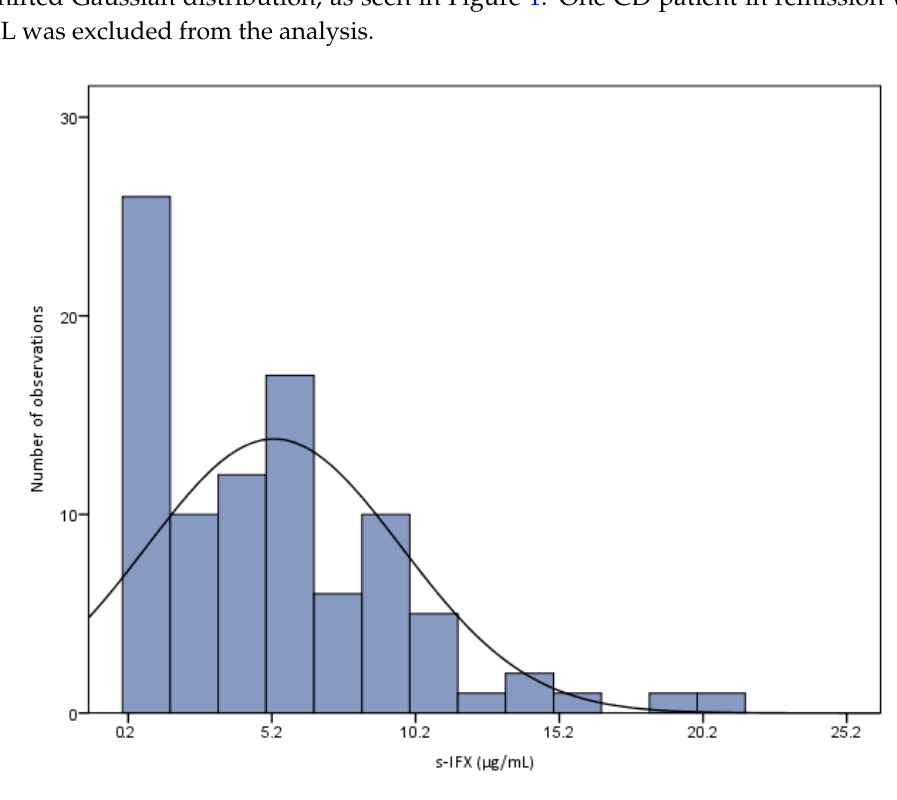
Figure 1. The distribution of serum infliximab (s-IFX) levels in 92 serum samples from 44 maintenance-treated pediatric IBD patients (one to four samples per patient) obtained immediately before the next scheduled infusion. Mean s-IFX trough level was 5.2 µg/mL (Range <0.2 to 21).